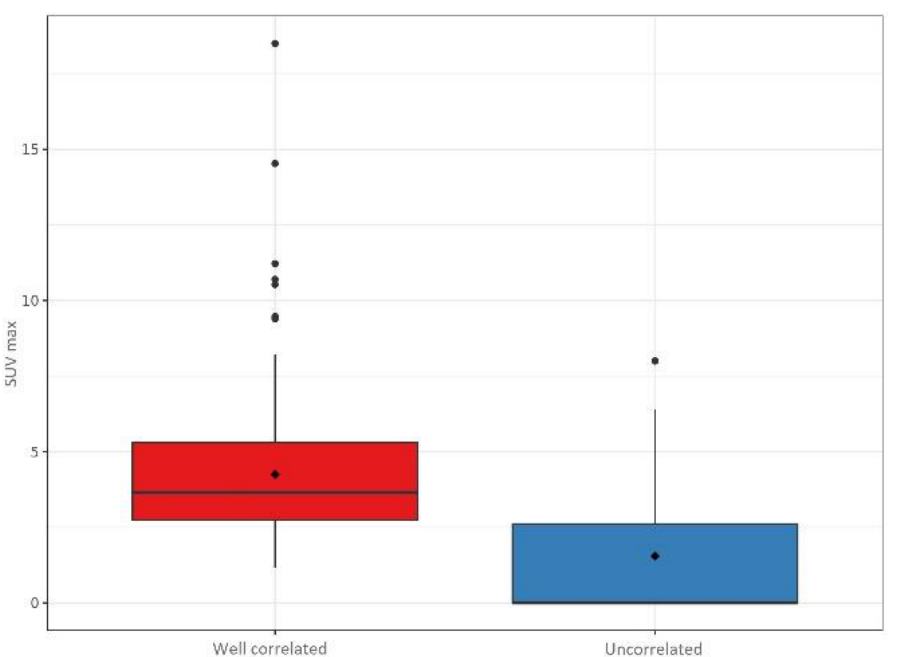
Figure 5. Maximum standardised uptake values (SUVmax) in the well-correlated group ( n = 220) and uncorrelated group ( n = 49).